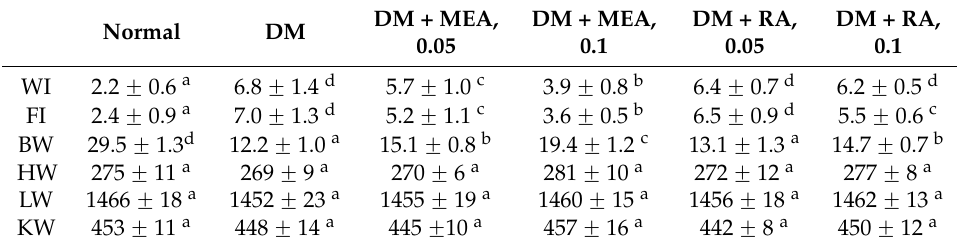
Water intake (WI, mL/mouse/day), feed intake (FI, g/mouse/day), body weight (BW, g/mouse), heart weight (HW, mg/mouse), liver weight (LW, mg/mouse) and kidney weight (KW, mg/mouse) of normal (non-diabetic), diabetic mice consumed normal diet (DM), or 0.05%, 0.1% MEA or RA for six weeks. Data are mean ˘ SD, n =